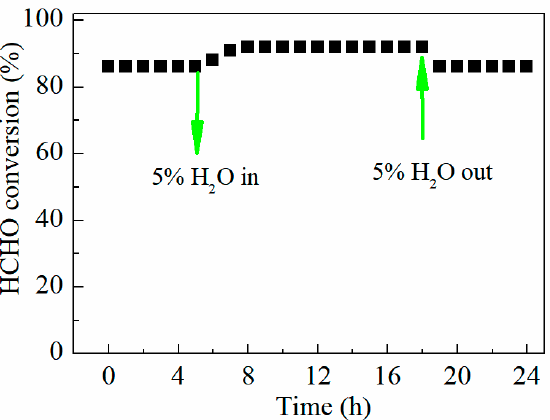
Figure 10. Effect of water vapor on catalytic performance of FMC-2:5:5 at 30 °C with 200 ppm HCHO, 21 vol% O 2 and N 2 (balance), WHSV = 36,000 mL g cat − 1 h − 1 .